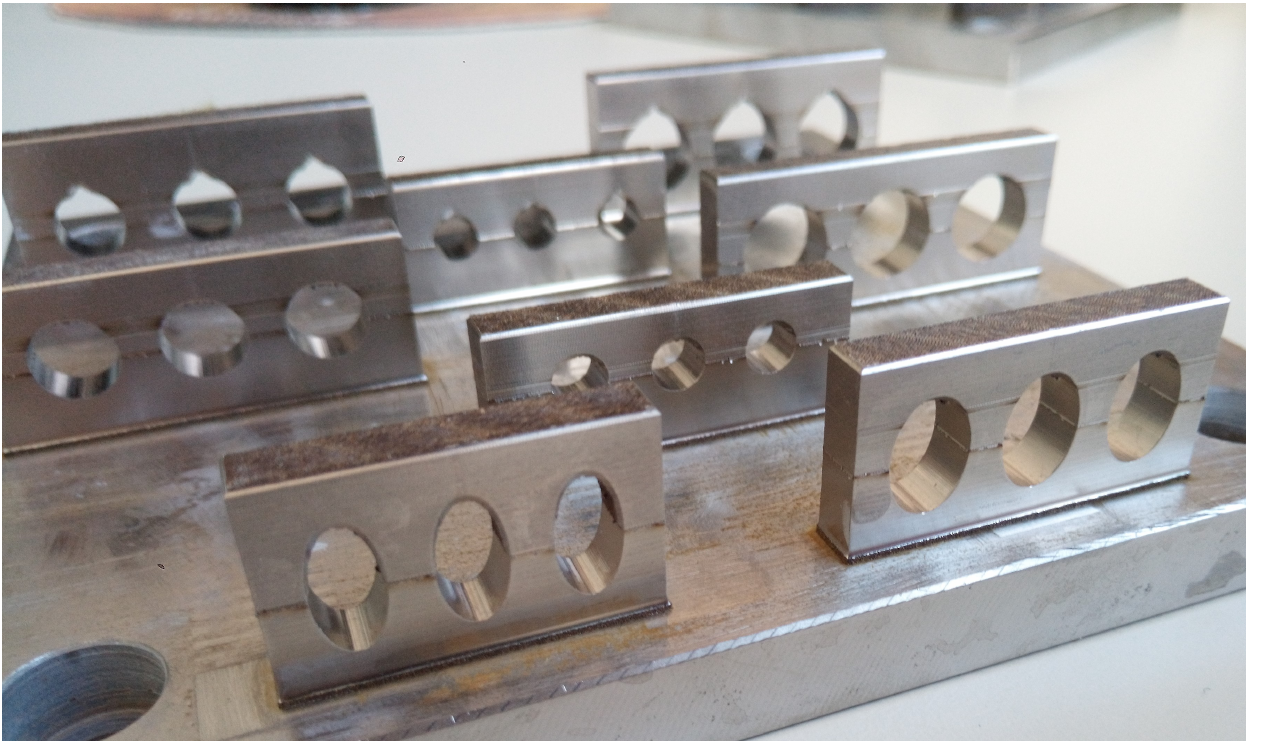
Figure 18. Different types of hybrid built bore